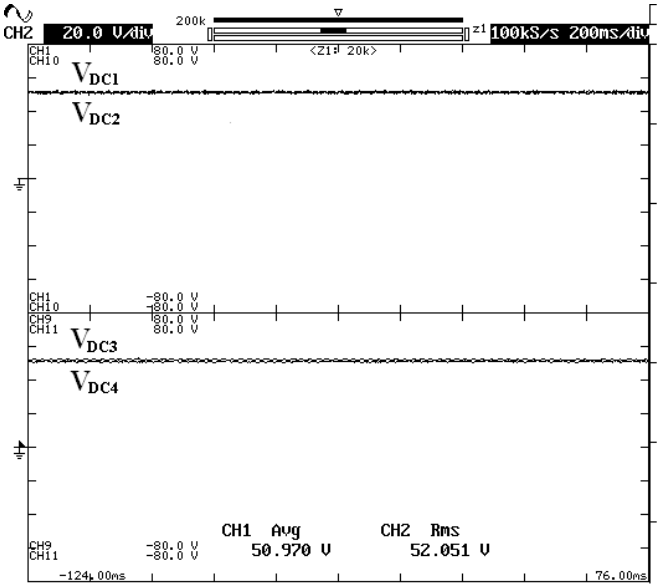
Figure 17. DC-link capacitor voltages ( V DC 1 - V DC 4 ) of the five-level DCMC-based STATCOM.